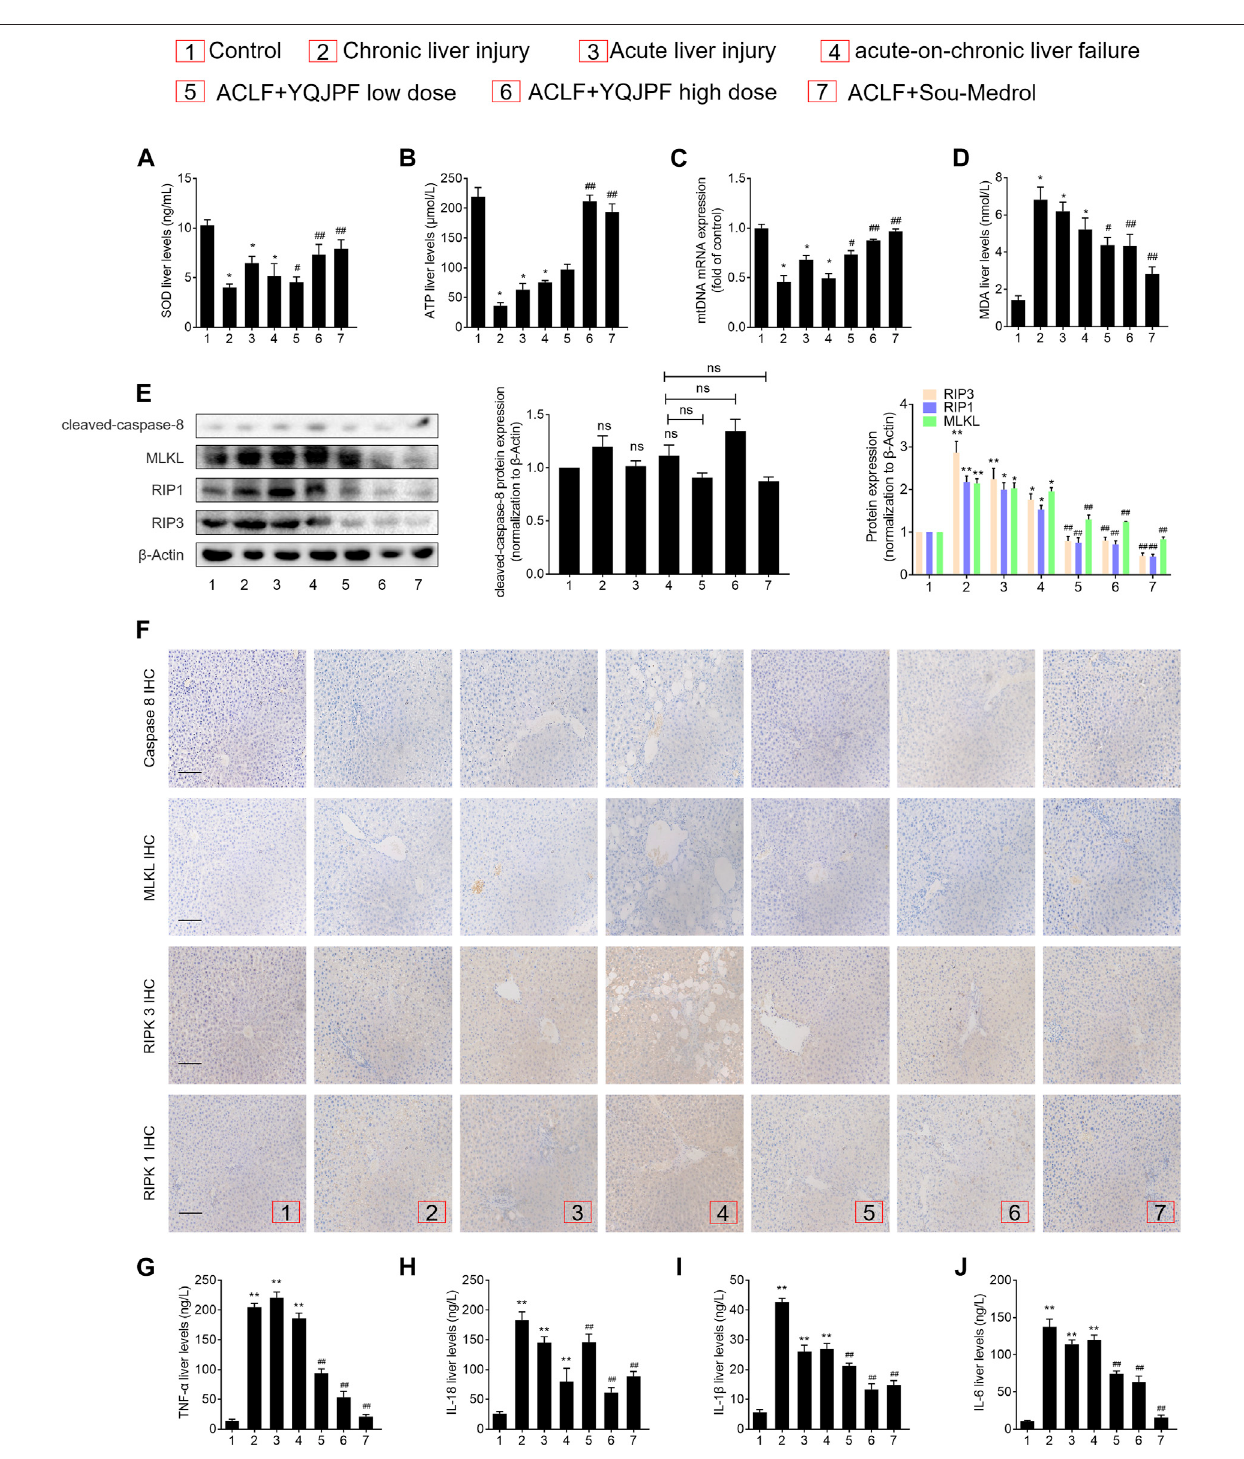
FIGURE10 | Disruption ofhepatocyte necroptosis, and not apoptosis, was required forthe action ofYQJPF in vivo. (A – D) MDA, ATP, GSH, and SOD levels in the rat livers were measured. (E) Western blot and quantitative analysis of cleaved caspase 8, MLKL, RIPK1, and RIPK3 expression in the rat livers. (F) Immunochemical staining and quantitative analysis of caspase 8, MLKL, RIPK1, and RIPK3 in liver tissues. Scale bar, 100 μ m. (G – J) Expression levels of IL-1 β , IL-6, TNF- α , and IL-18 in the rat livers were detected by ELISA. Data are expressed as mean ± SD ( n (cid:2) 8) *vs. control group, # vs. ACLF group; * p < 0.05, ** p < 0.01; # p < 0.05, ## p < 0.01.